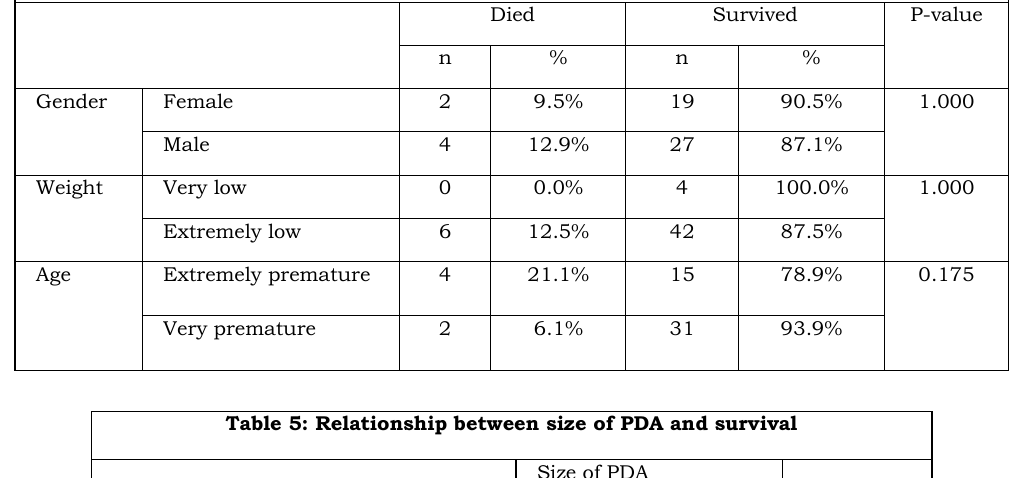
Table 5: Relationship between size of PDA and survival